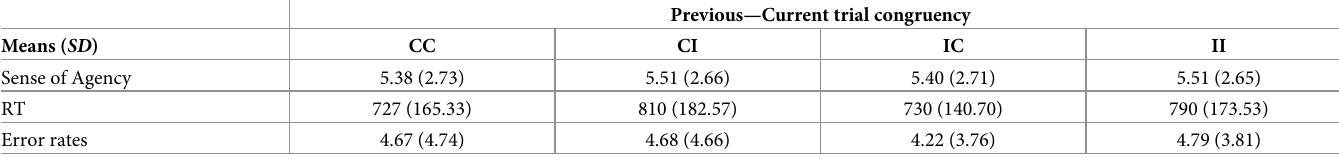
Previous—Current trial congruency